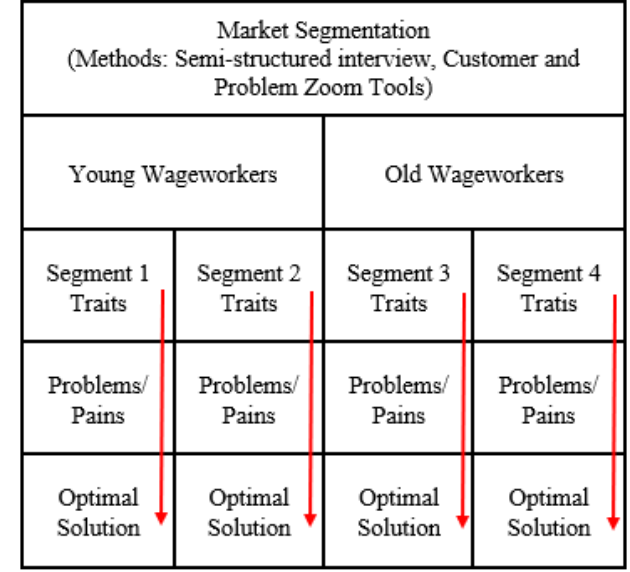
Figure 1. The research framework. Figure 1.